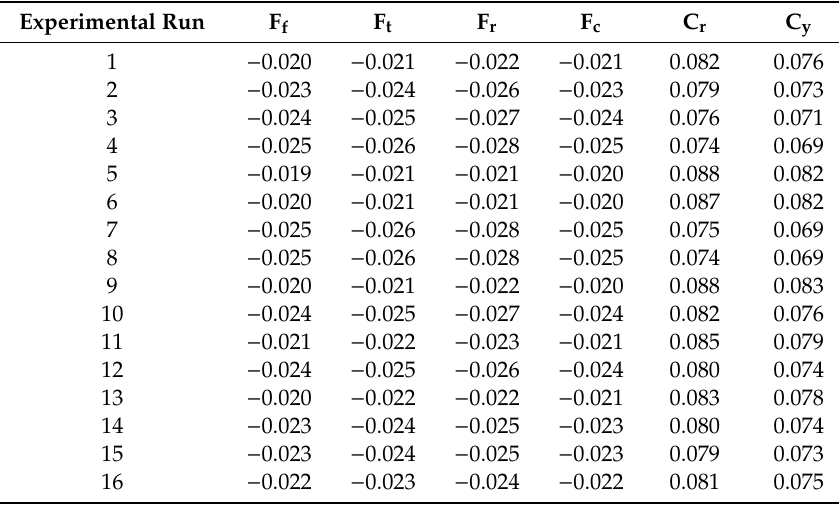
Table 7. Weighted normalized values of responses.